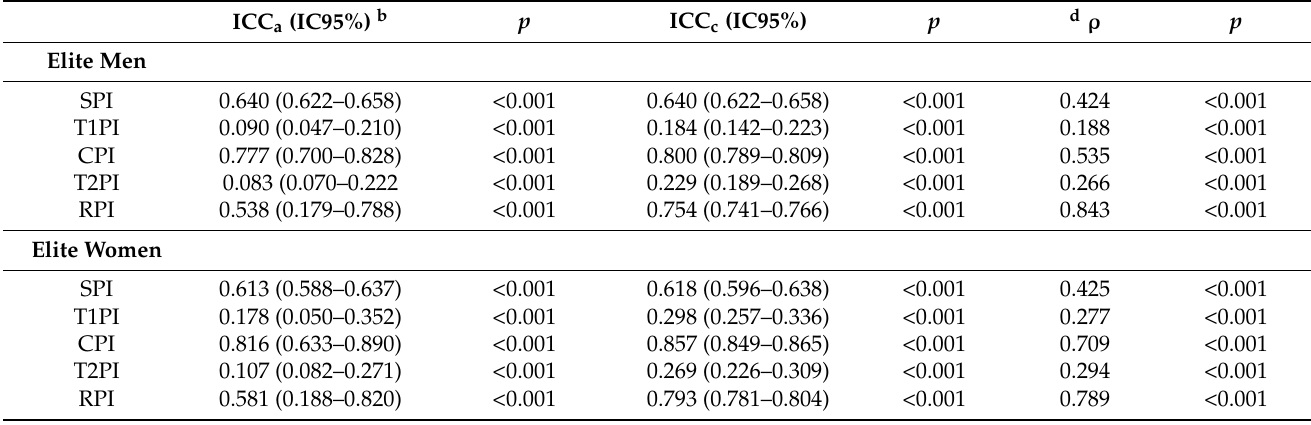
Table 4. Intraclass correlation coefficient of absolute agreement and concordance, and Spearman range correlation coefficient, between the overall performance indicator and the three segments in the years